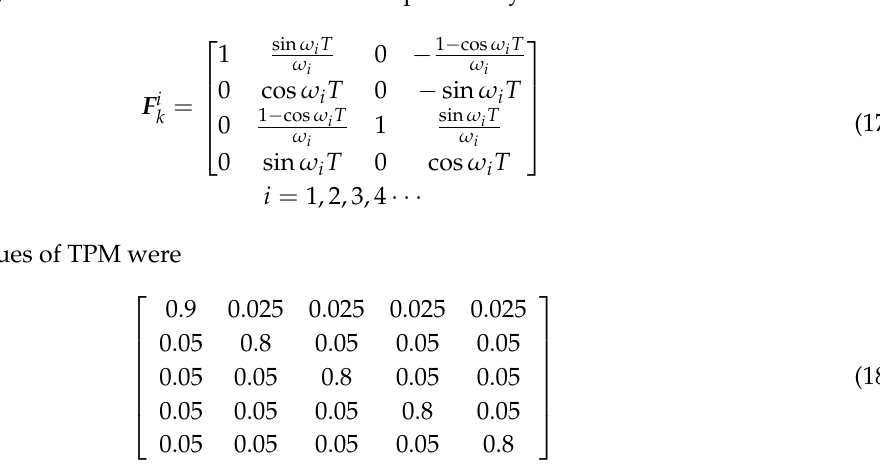
Figure 10. Scenario of the SD-IMM algorithm.